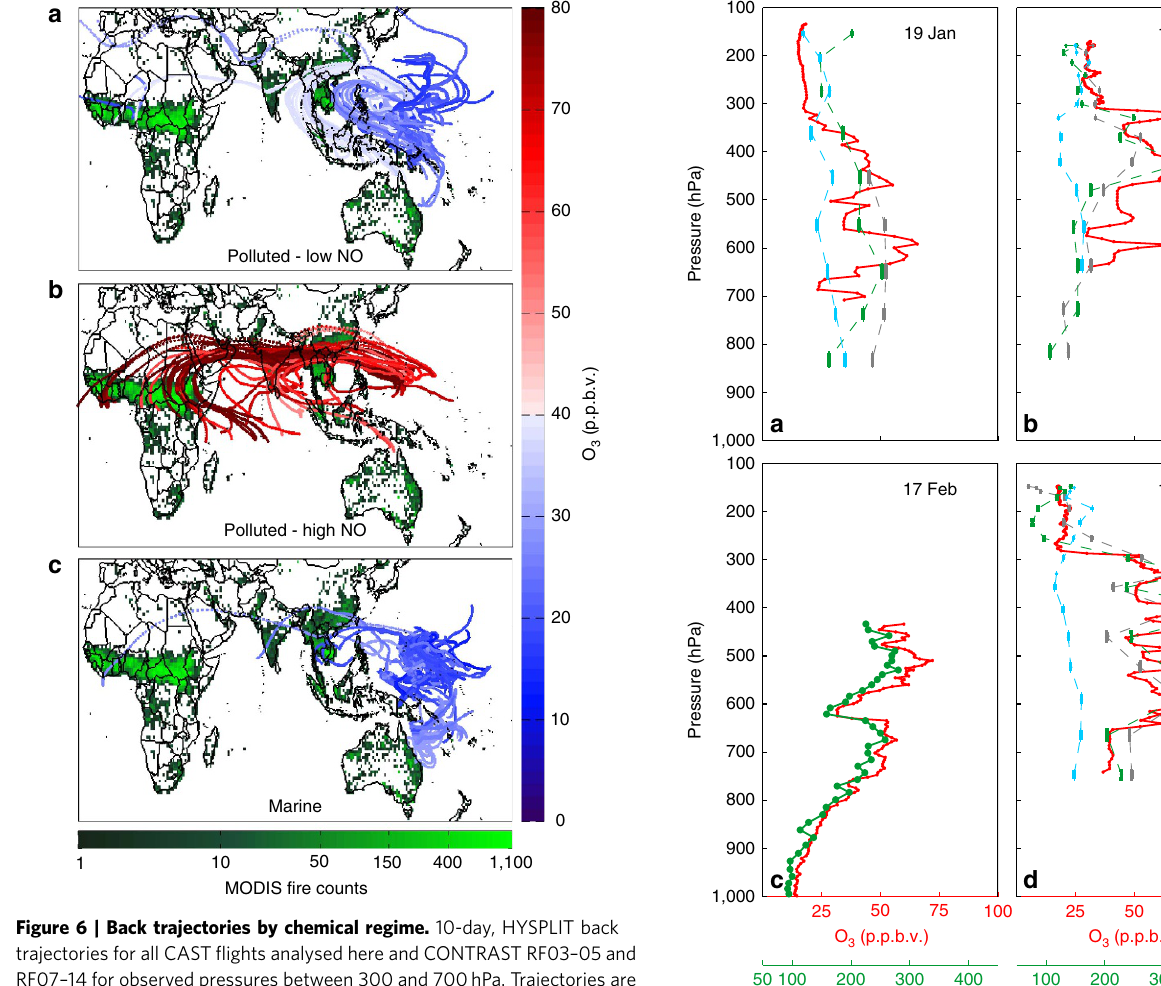
NATURE COMMUNICATIONS|7:10267|DOI: